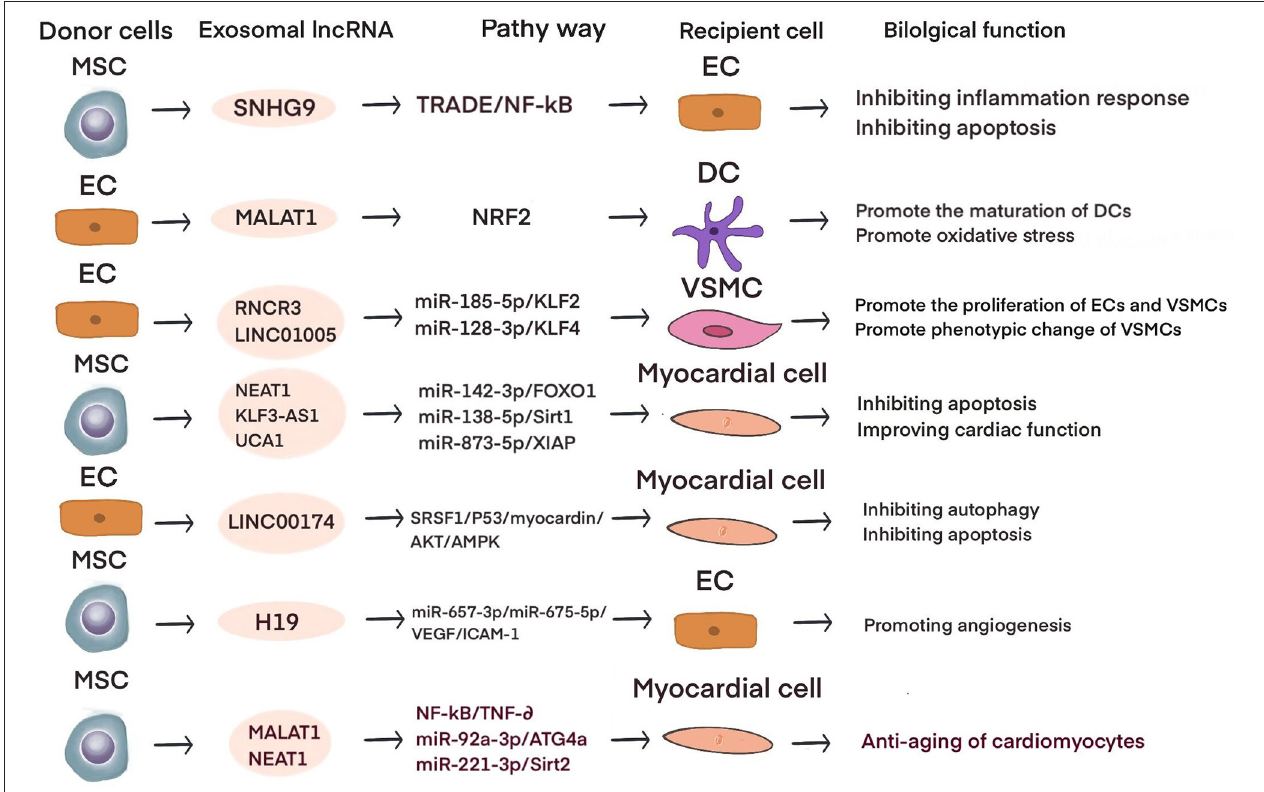
FIGURE 2 | The role of exosomal lncRNA in preclinical studies of cardiovascular diseases.